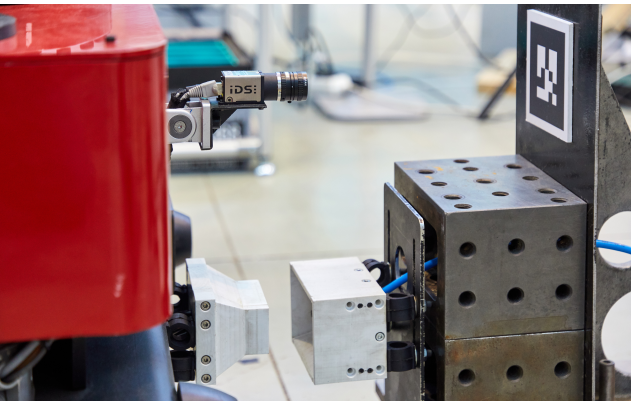
Figure 3. AIMM performing the accurate docking by detecting the Fiducial marker with the